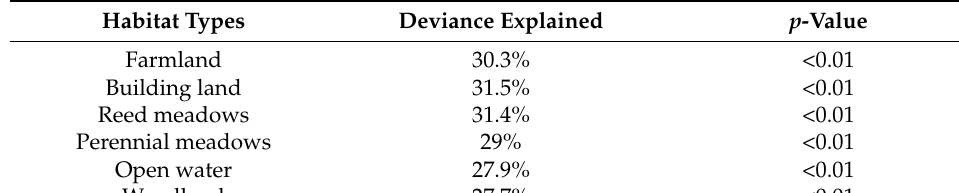
Table 4. Importance of habitat types in determining bird community compositions.